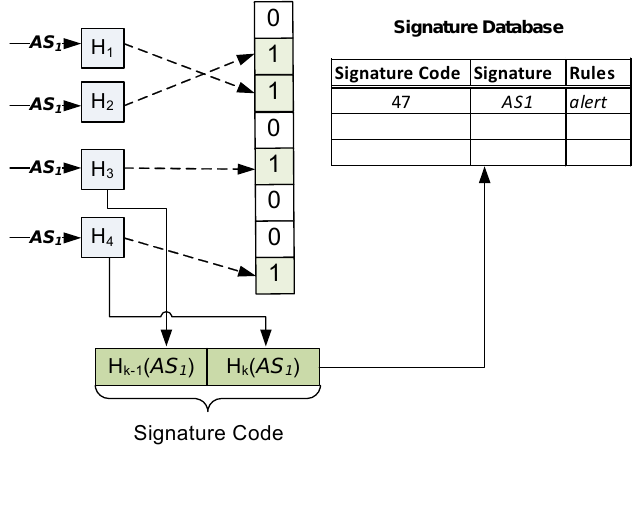
Figure 4. Generation of signature-code for the signatures having same